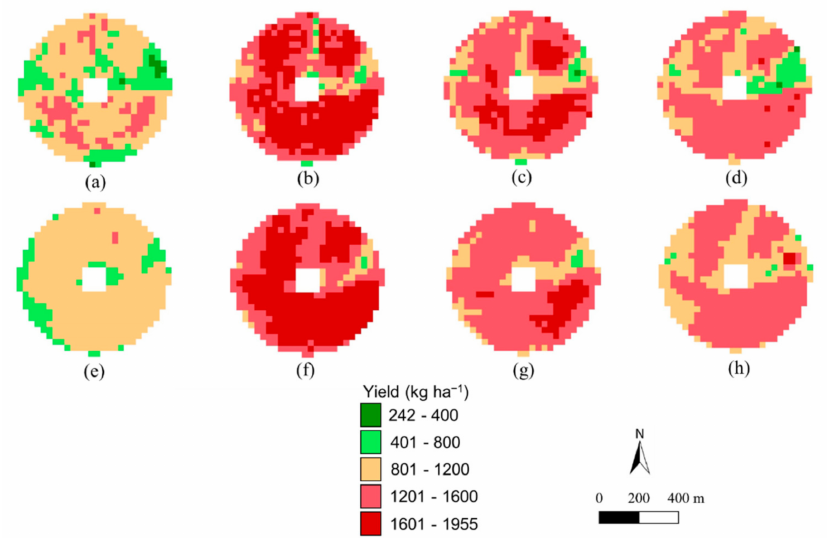
Figure 6. Geospatial variations in ( a – d ) observed and ( e – h ) simulated cotton lint yield at field #26,